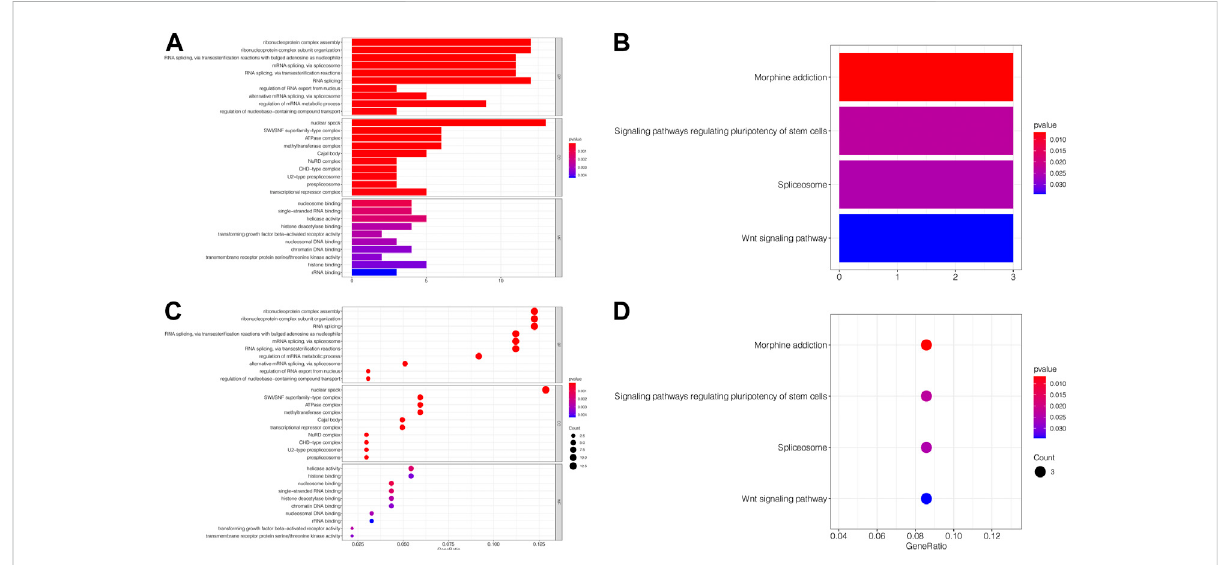
FIGURE 8 GO terms and the KEGG pathway. (A) Histogram presentation of the top 10 positions of GO terms of target genes in biological processes (BP), cellular components (CC) and molecular functions (MF) of biology; (B) Histogram presentation of pathways related to the differentially expressed